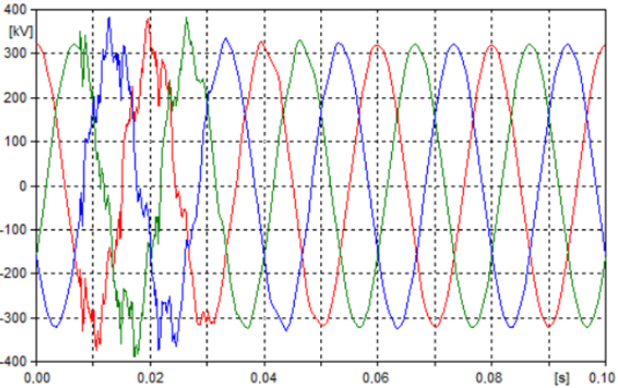
Figure 6. Voltage waveform of a multi-system line with different voltage levels for transmission line 110 kV.